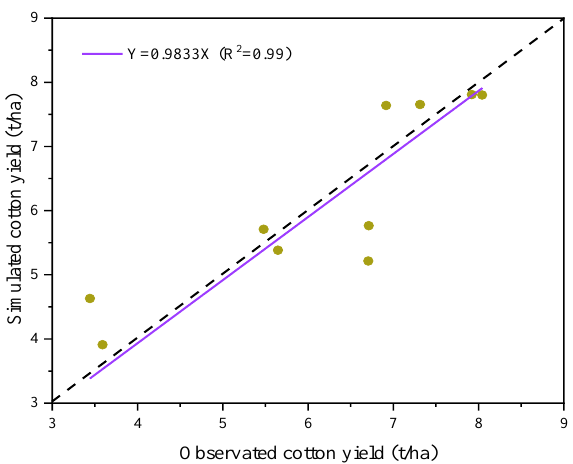
Figure 12. Comparison between observed and simulated aboveground biomass for different irrigation and salinity treatments ( a – j ). (The dots represent the measured data, the lines represent the simulated values, the error bars represent standard deviations. W1, W2, W3 and W4 represent irrigation amount of 22.5, 30, 37.5 and 45 mm. S1, S2 and S3 represent the soil salinity of 0.2%, 0.4% and 0.6%.)